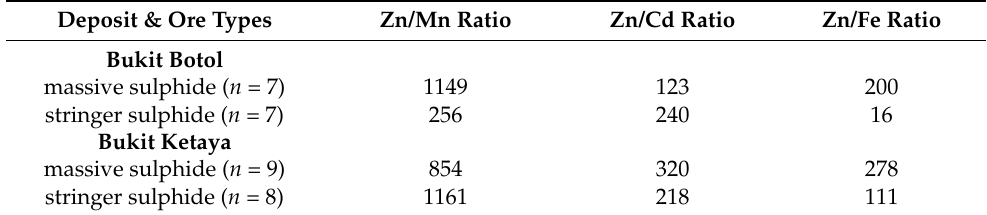
Table 5. Average Zn/Mn, Zn/Cd, and Zn/Fe ratios of sphalerites from the Bukit Botol and Bukit Ketaya